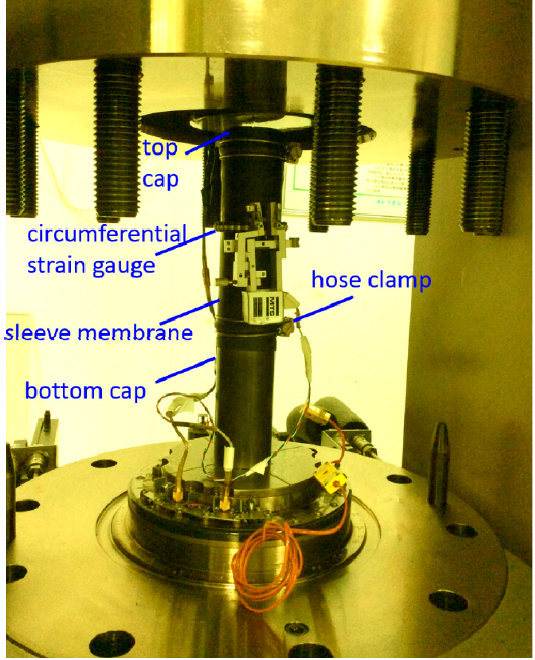
Figure 3. Experimental set-up for the triaxial tests.